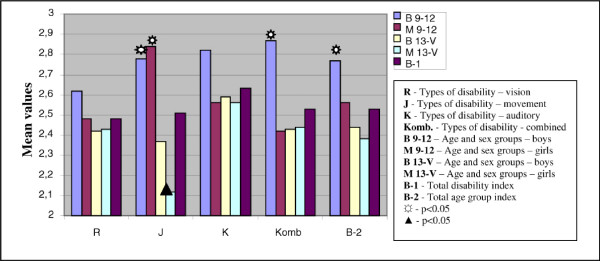
The self-worth index of the schoolchildren with disabilities. The relationship of the self-worth index of the schoolchildren with disabilities and the respondents' age (9–12, 13-old), sex (girls, and boys), and the type of disability(vision, movement, auditory, combined).